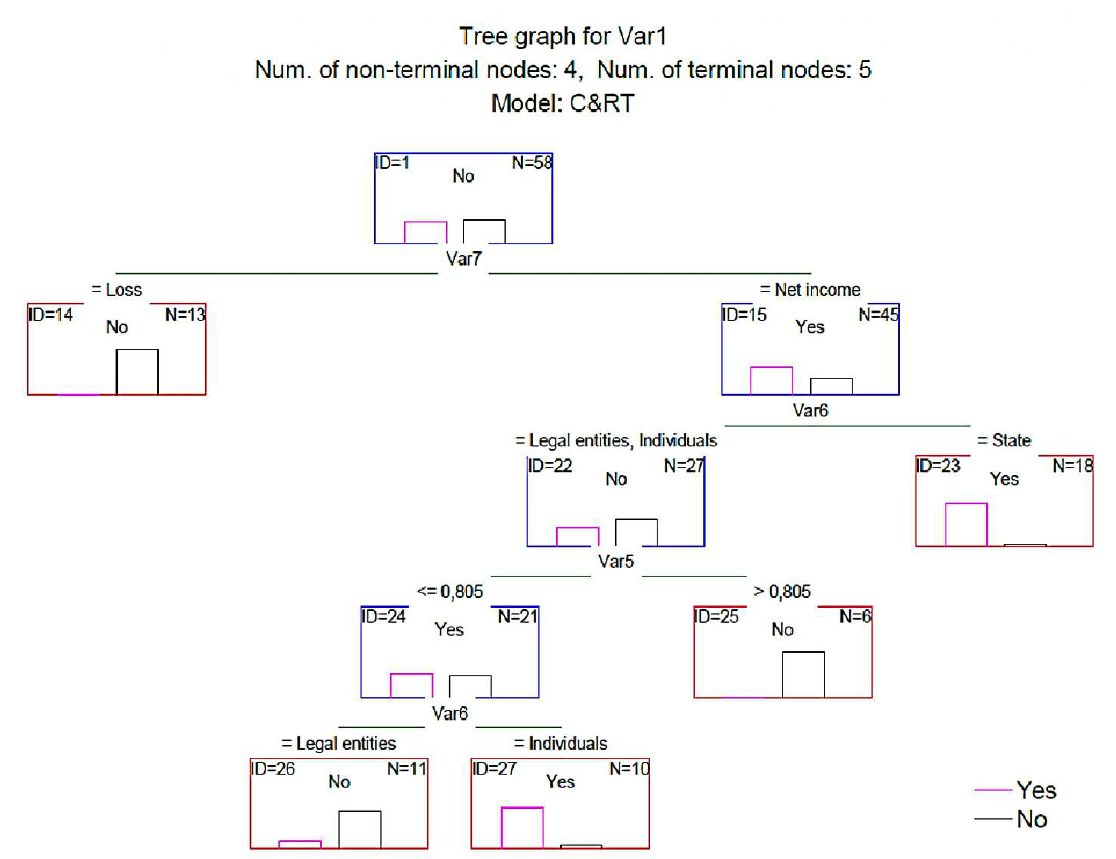
Figure 1. Classification tree related to factors determining a dividend